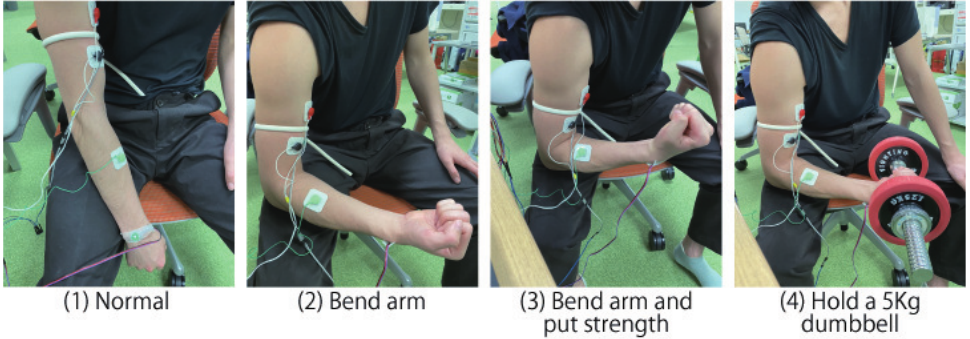
Figure 3. Four types of state using muscle.